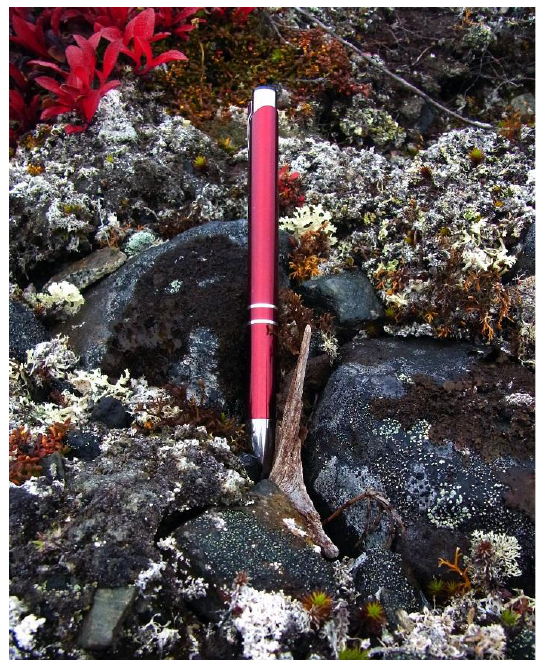
Figure 5: Subalpine heath with non-sorted circles close to Lake Torneträsk by Abisko in northern Lapland. Near the centre of the circle, s small megafossil pine remnant is exposed by frost heave. Radiocarbon-dating yielded AD 1220: Photo Leif Kullman, 14 September 2013.